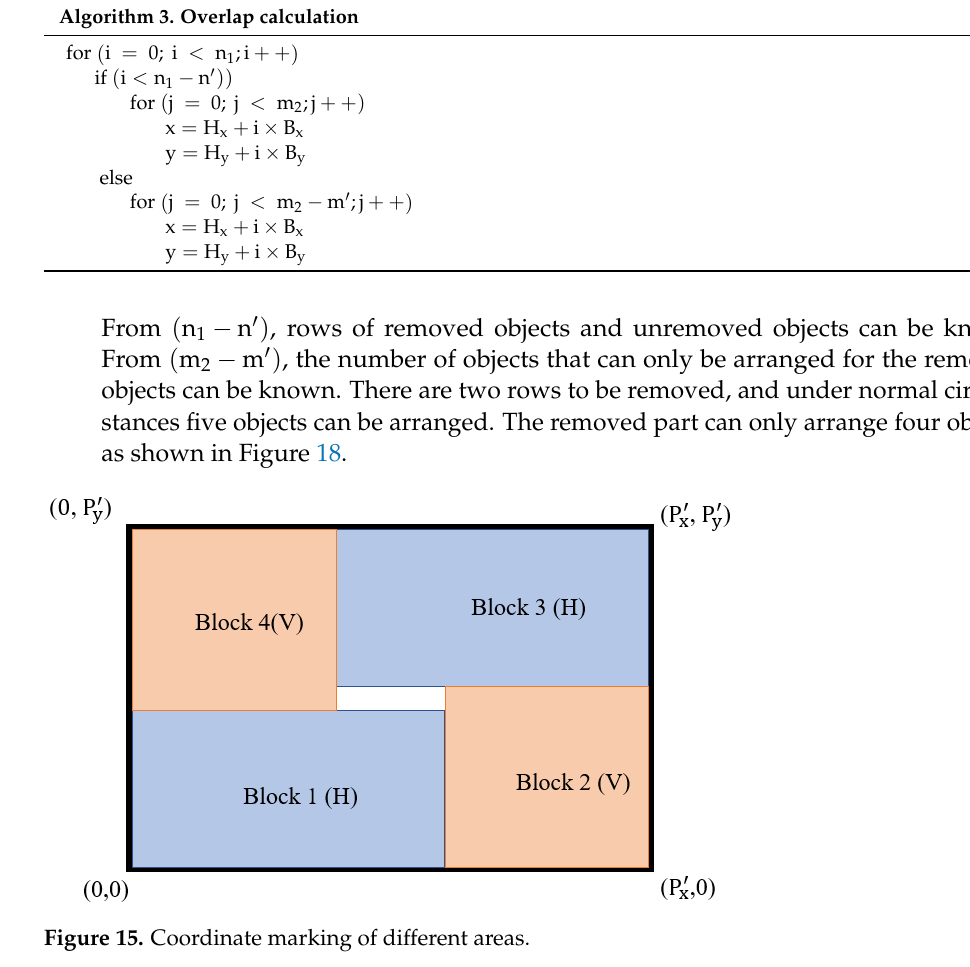
Figure 14. The area after calculation when Block 2 and Block 4 are overlapped.